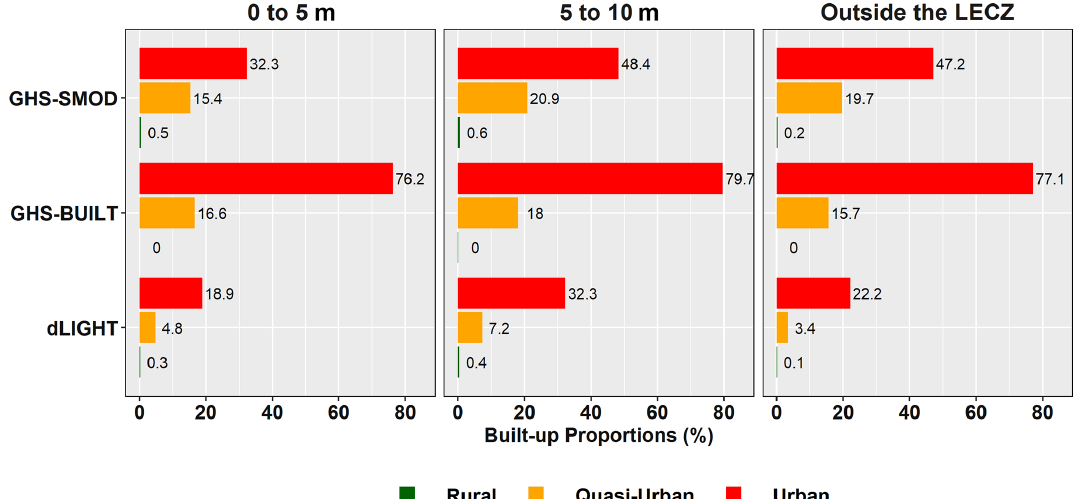
Figure 16. Built-up density (%) of urban, quasi-urban and rural areas by urban-proxy data set, using the MERIT DEM elevation source.